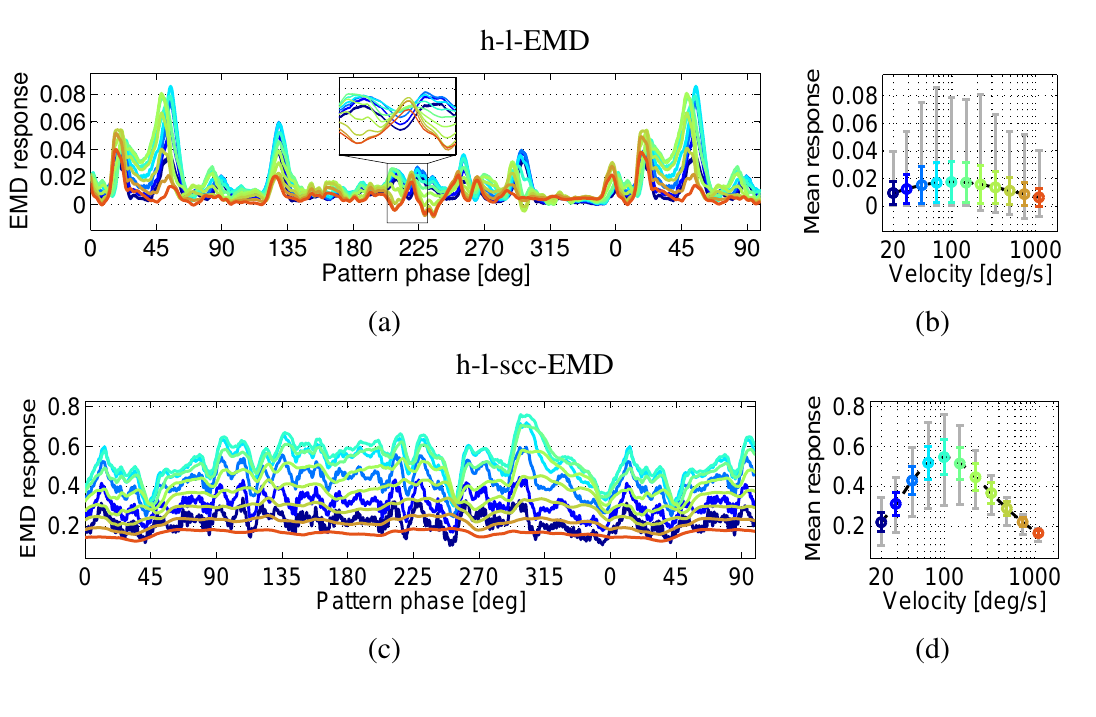
Figure 8. Time dependent responses to a natural panoramic image (see Figure 4 no. 1, park scene) moving at different constant velocities ( a and c ), and velocity dependence of averaged responses with standard deviation (coloured) and the minimum to maximum response range (grey) ( b and d ). (a, b) h-l-EMD array and (c, d) h-l-scc-EMD array. The h-l-EMD array shows a strong pattern dependency. The responses of the (s)cc-EMDs arrays show a smaller pattern dependency which is reduced for larger